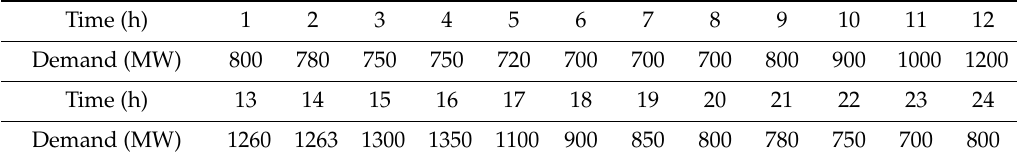
Table 16. Demand forecasting over 24